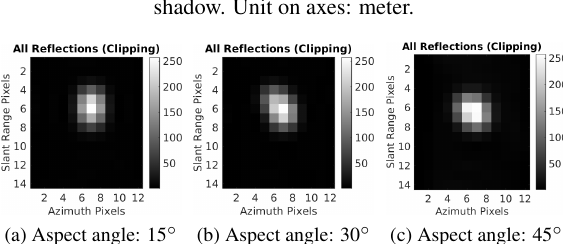
Figure 11. Simulated SAR images for street signs (spotlight mode) with an signal incidence angle of 40 ◦